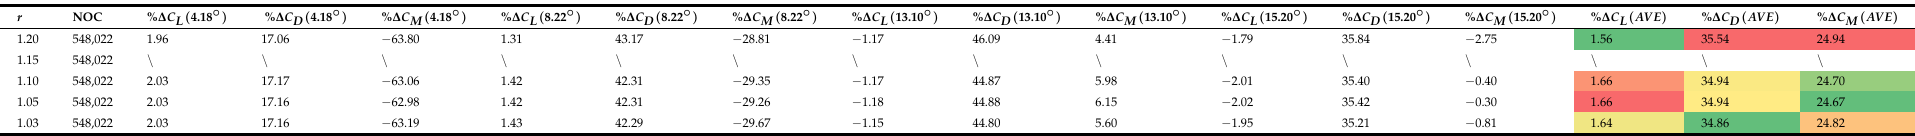
Table 14. Comparison of results of C-mesh based on various layer-wise growth rates with that of experimental benchmark data adopted from [25] in relative differences.